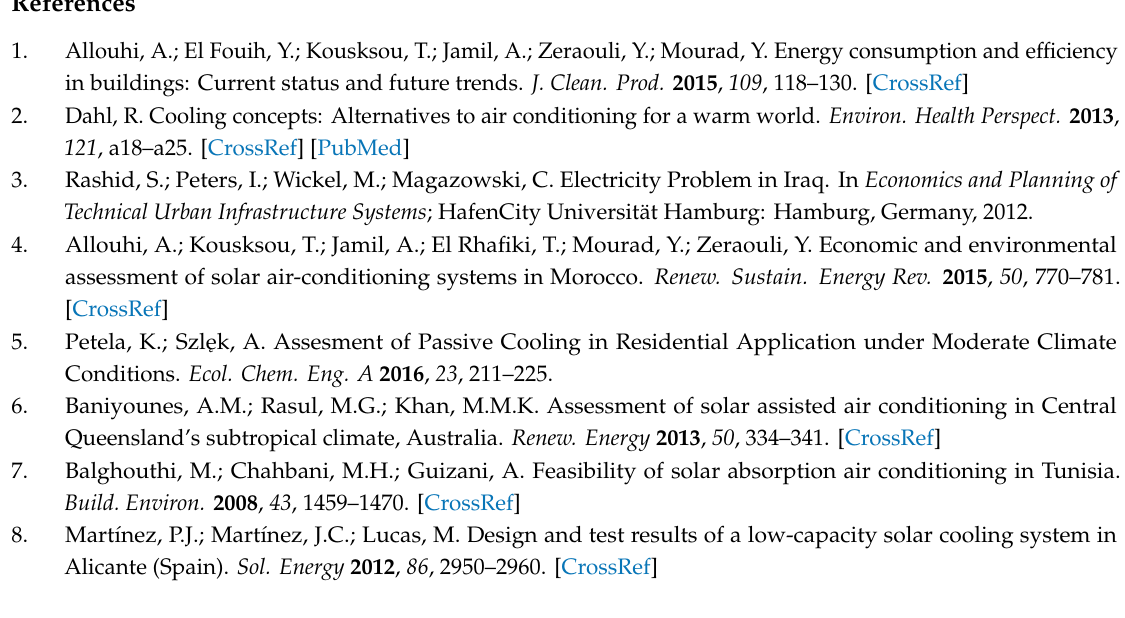
Figure A1. Layout diagram of the modern domestic solar house ( a ) ground floor ( b ) first floor. Table A1. Wall layers details.